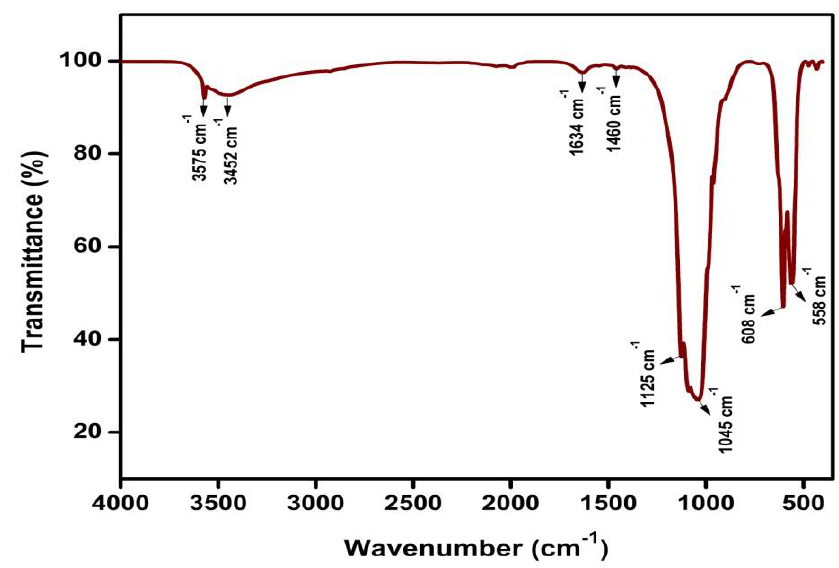
Figure 2. FTIR spectrum of Ni 2+ -doped HApNPs calcined at 500 °C.